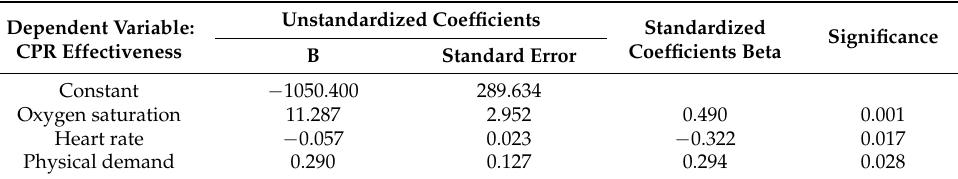
Table 3. Multiple linear regression analysis to model the relationship between global CPR effective- ness scores and heart rate, blood oxygen saturation and physical demand workload.